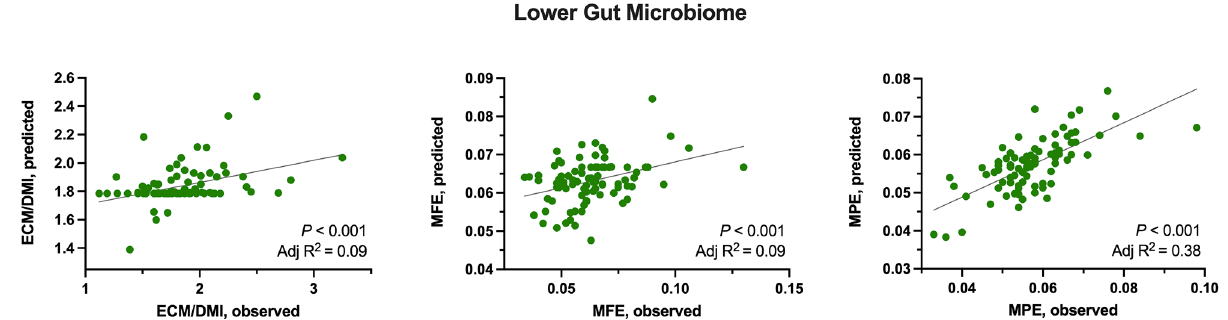
Figure 7. Correlation of the lower gut microbiome with each associated milk production efficiency trait (kg/ kg of DMI) in the linear discriminant analysis of effect size (LEfSe). Associated traits were milk production efficiency (ECM/DMI), milk fat production efficiency (MFE), and milk protein production efficiency (MPE). Significance was declared at P ≤